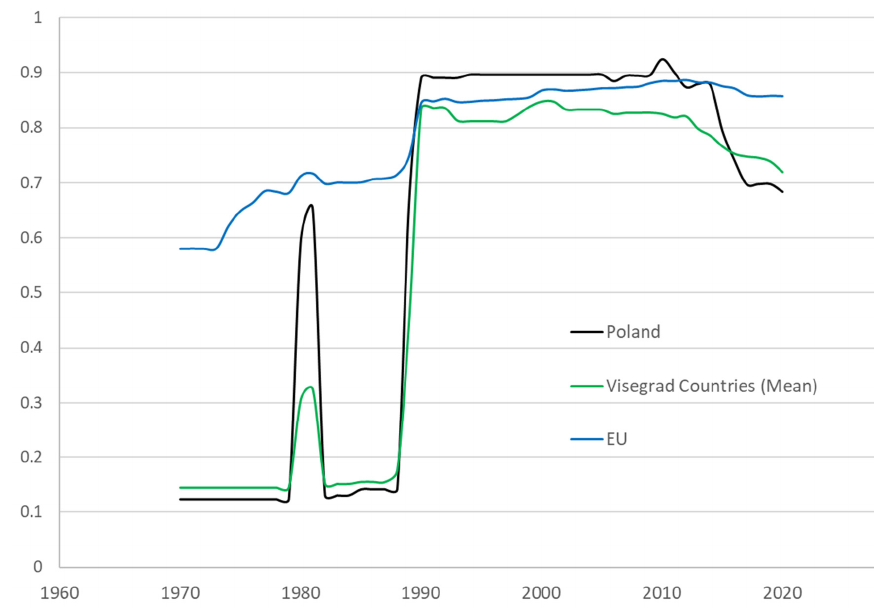
Figure 16. Civil society participation index. Source of data: VDEM [51].